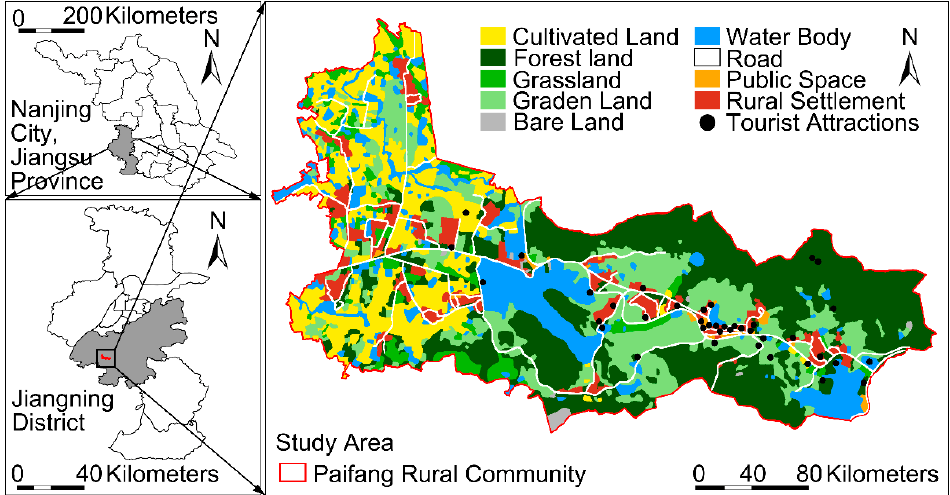
Figure 3. Location of the Paifang rural community.